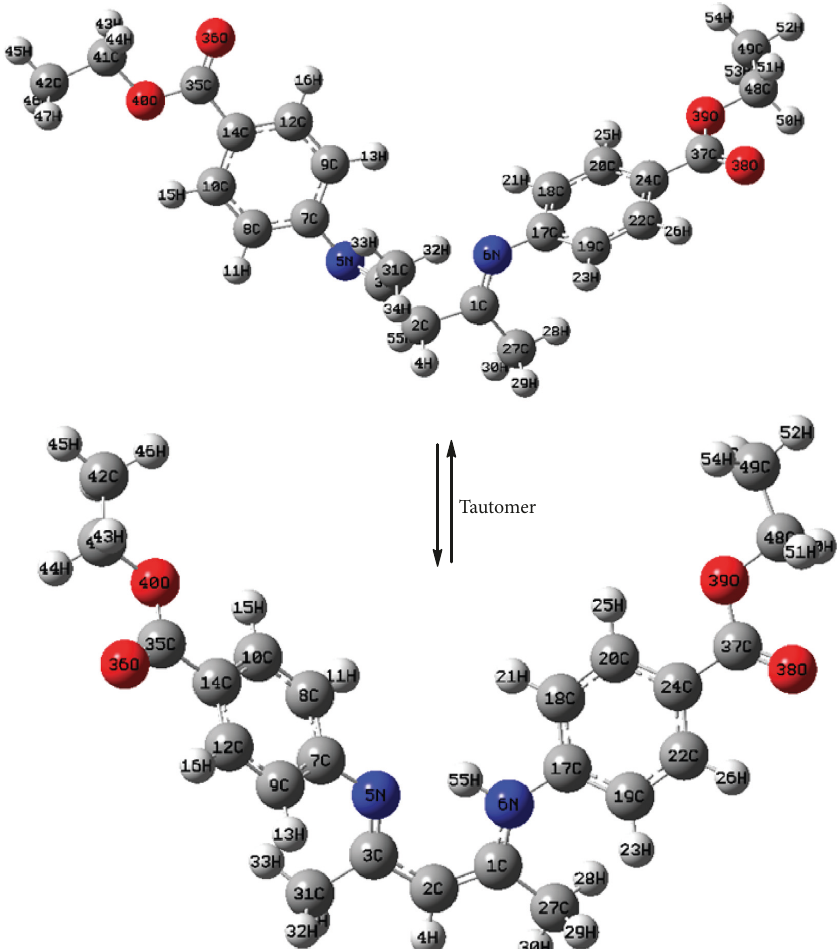
Figure 2: Structure of the model compound used to evaluate M06-2x/6-31G(d) for the optimized structure of the β -diketimine Schiff base ligand 1 and its tautomeric